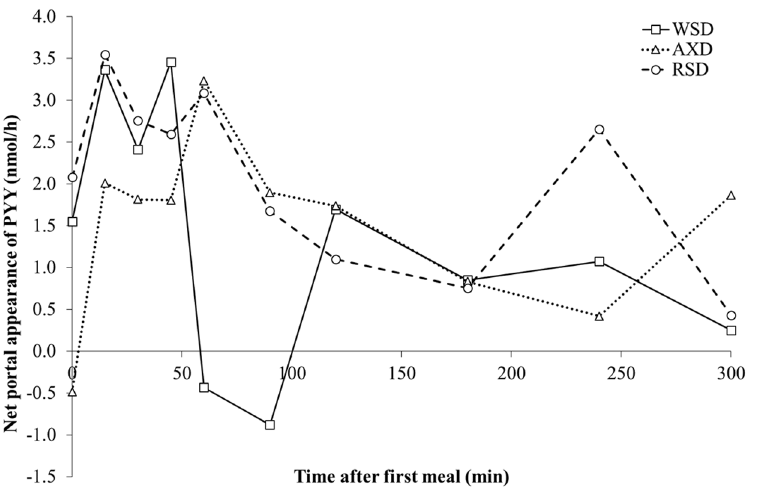
Fig 1. Net portal appearanceof PYY in pigs fed WSD, AXD, and RSD. Net portal appearanceof PYY followingthe first daily meal (0 min). Valuesare means, n = 6; P Diet = 0.19, P Time = 0.03, P Diet × Time = 0.14). The solid lines represent means from pigs fed the Western-style diet (WSD); dotted lines represent means from pigs fed the arabinoxylan-rich whole-grain diet (AXD); the dashed line represent means from pigs fed the resistant starch-rich diet